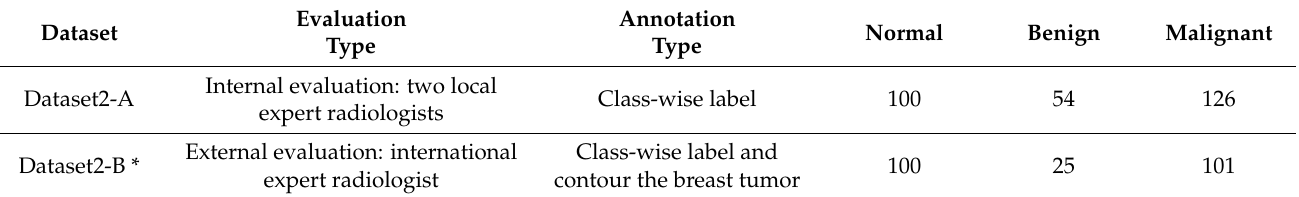
Table 1. Real benchmark private breast images dataset. The class-wise labels (normal, benign, and malignant) were evaluated twice with three local and international expert radiologists.